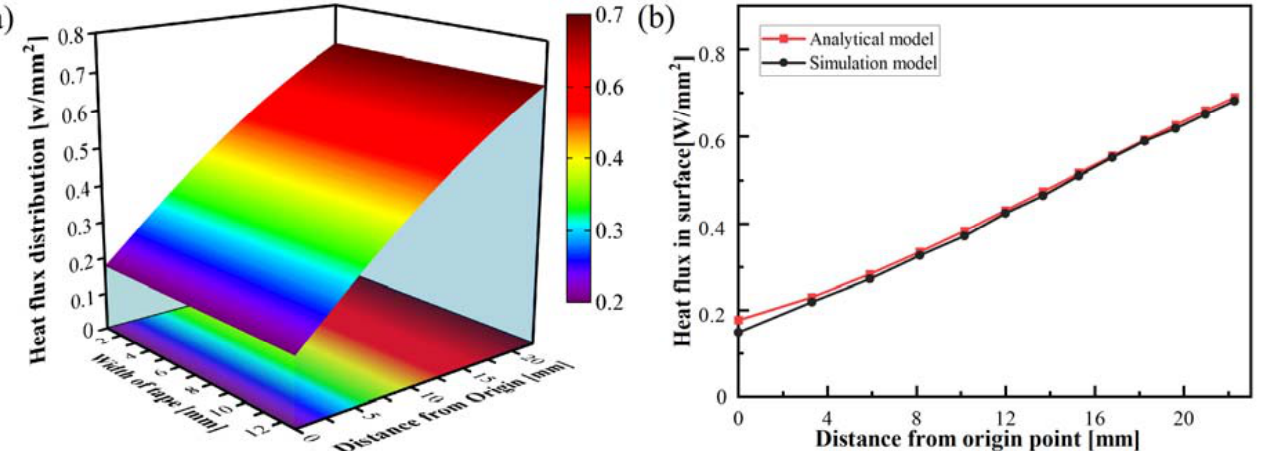
Figure 9. Heat flux distribution obtained by the theoretical model ( a ) and comparison with simulation model results ( b ).